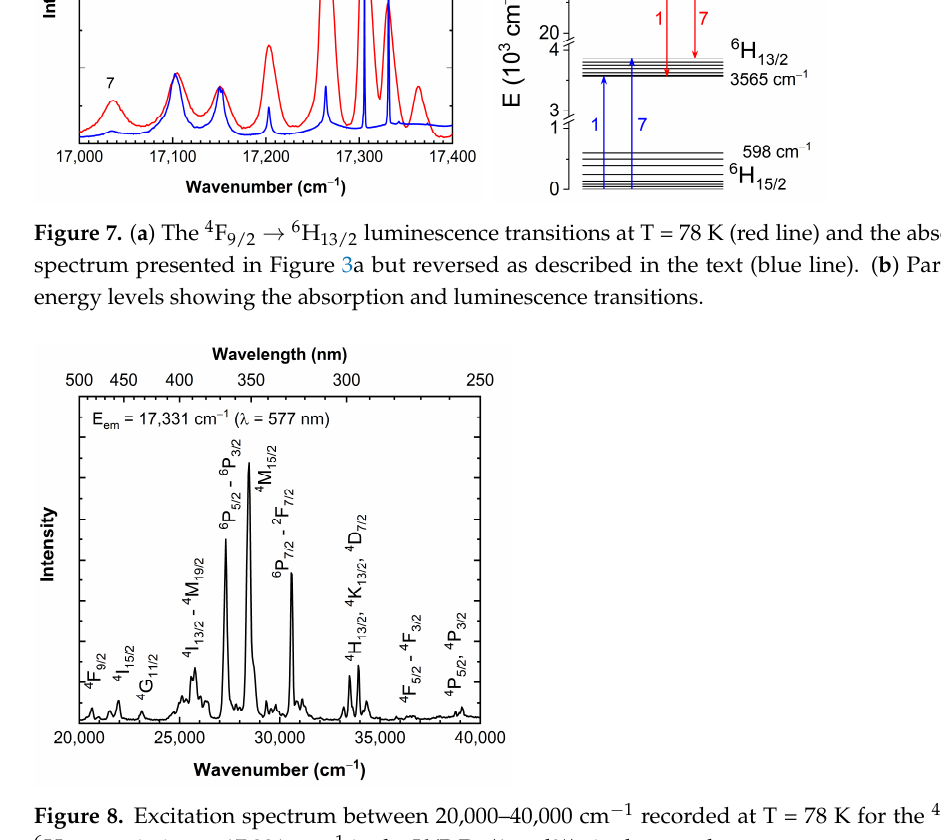
Figure 6. A detailed part of the luminescence spectrum at T = 78 K corresponding to the 4 F 9/2 → 6 H 15/2 transition. The numbered scale (1) on the top proves the correspondence of the luminescence transitions to the Stark components of the ground 6 H 15/2 state partly found from absorption. Scale (2) corresponds to a hot state of the 4 F 9/2 multiplet. The Stark components of the 6 H 13/2 multiplet can be determined from both the absorp- tion and luminescence measurements. It is remarkable, that the detailed structure of the 4 F 9/2 → 6 H 13/2 emission corresponds almost perfectly to the reversed absorption spectrum shown for the 6 H 15/2 → 6 H 13/2 transition at 8 K in Figure 3a. The reversion point was defined by the overlay of the emission line at 17,331 cm −1 with the absorption line at 3564.7 cm −1 . This comparison demonstrates the consistency of the results obtained by the two spectro- scopic methods.